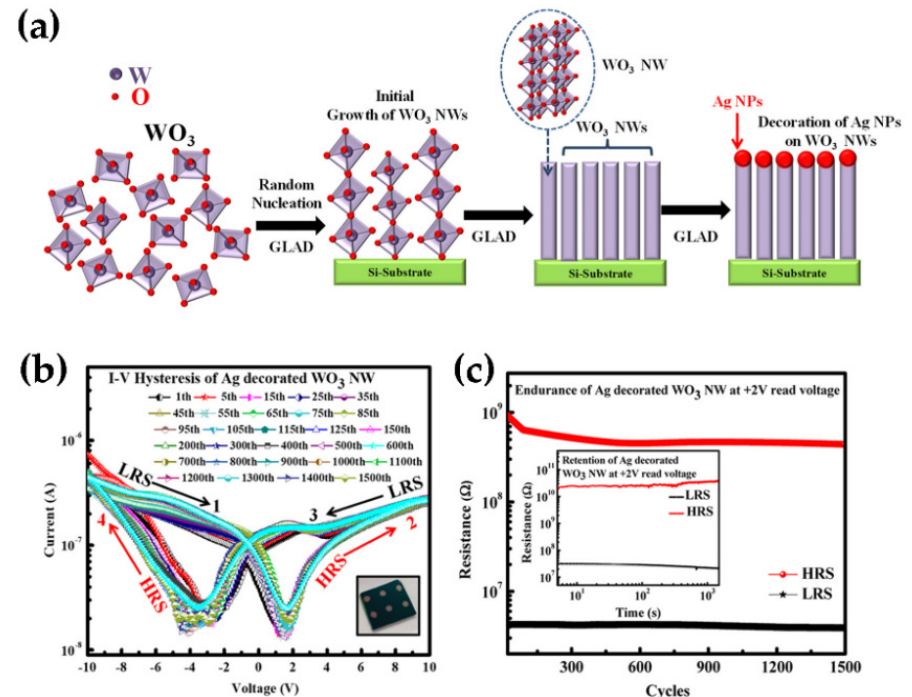
Figure 20. ( a ) Schematic illustration of the growth processes of Ag-decorated WO 3 NWs. ( b ) Semi-logarithmic scale volt-ampere characteristic curve of Ag-decorated WO 3 NWs device at room temperature. The inset shows the image of Ag-decorated WO 3 NWs devices. ( c ) Switching durability of Ag-decorated WO 3 NWs at +2 V read voltage. The inset shows the data retention characteristics of Ag-decorated WO 3 NWs devices. Reprinted (adapted) with permission from [105]. Copyright {2021} American Chemical Society.